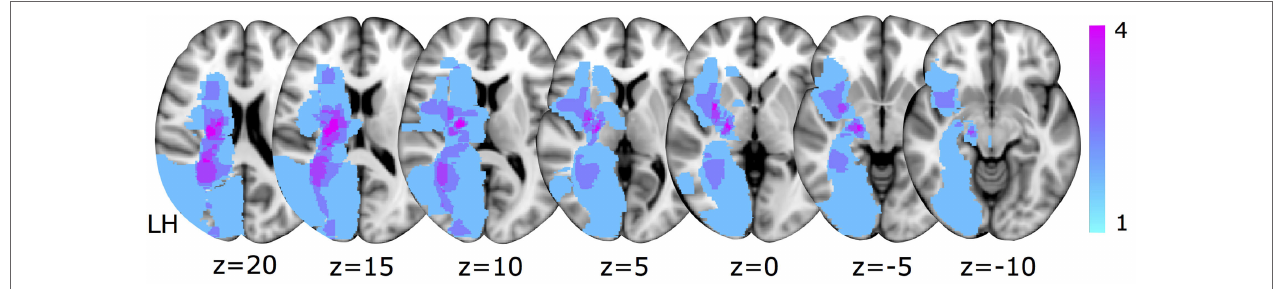
FigUre 1 | Lesion locations for the eight subjects overlaid on axial Montreal Neurological Institute T1 slices. The color bar indicates the number of subjects with lesioned tissue in a particular voxel. LH indicates the lesioned